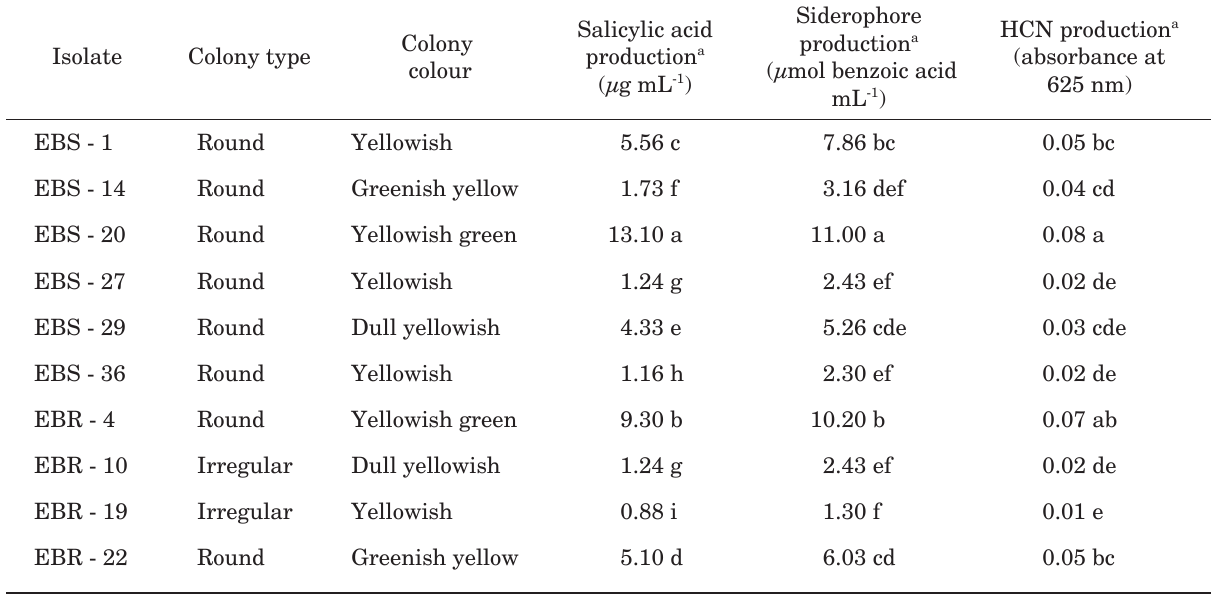
Table 2. Cultural characteristics and secondary metabolites produced by effective endophytes.